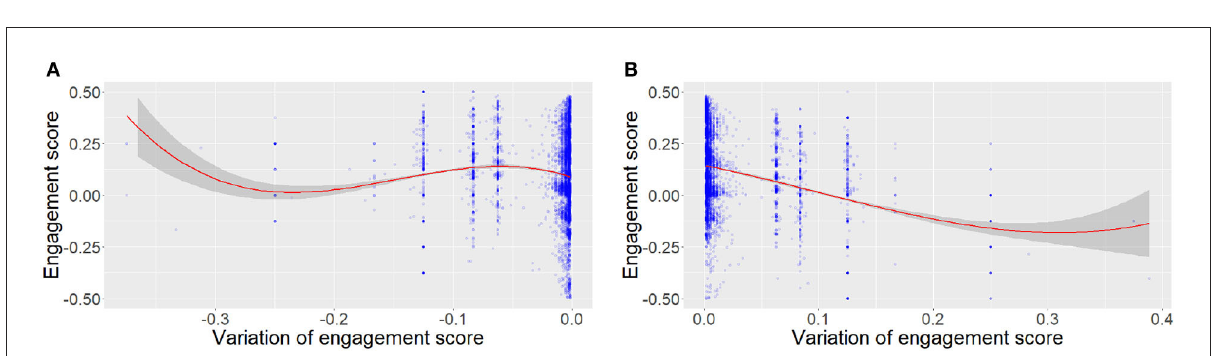
FIGURE3 Variation of engagement in NoXi according to the current level of engagement. (A) Positive variations. (B) Negative